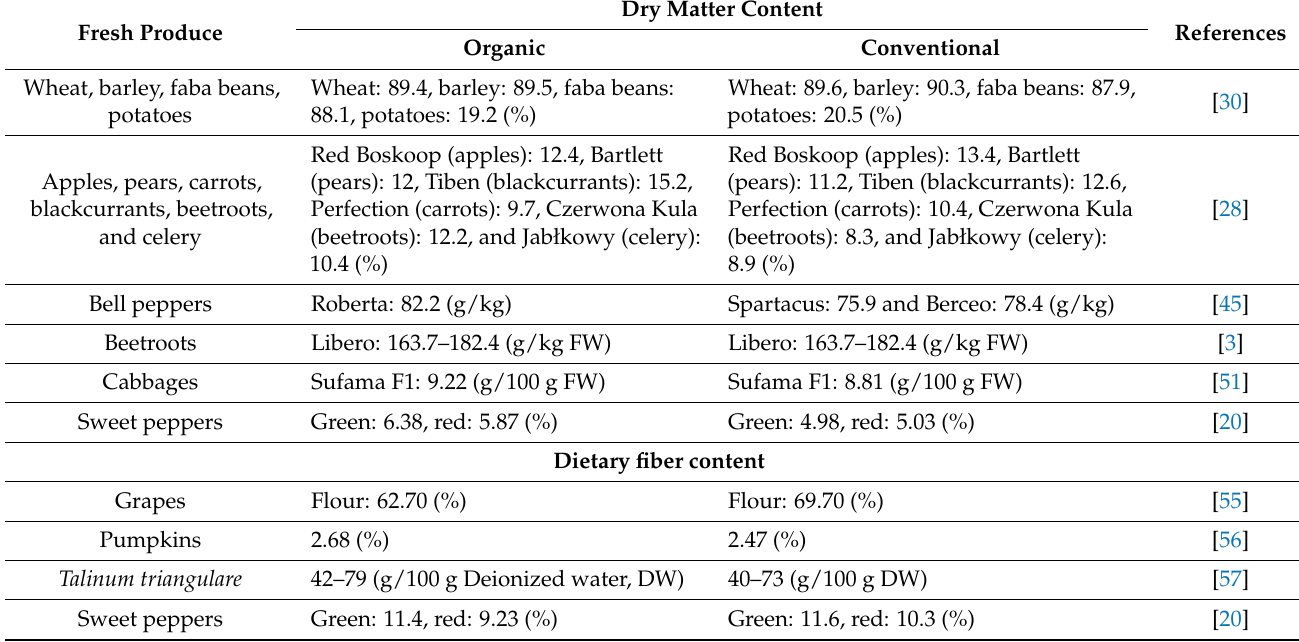
Table 7. Dry matter and dietary fiber content of organic and conventional fresh